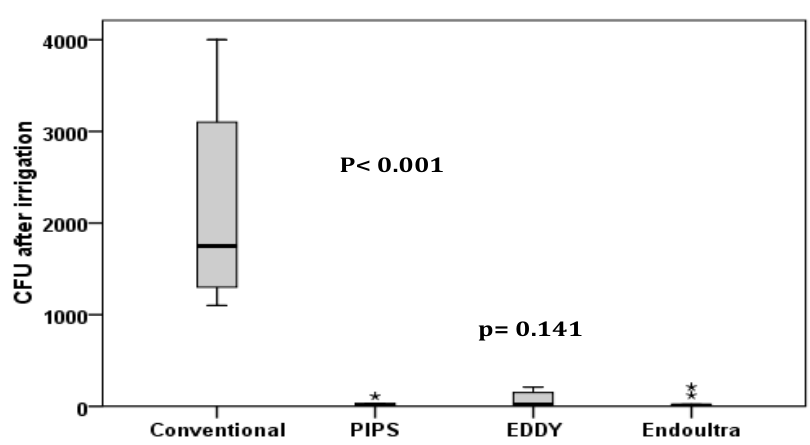
Figure 1. Distribution of CFU among groups. The decrease of CFU was significantly lower after conventional irrigation ( p < 0.001). However, no significant difference was found between photon-induced photoacoustic streaming (PIPS), EDDY and EndoUltra ( p = 0.141).